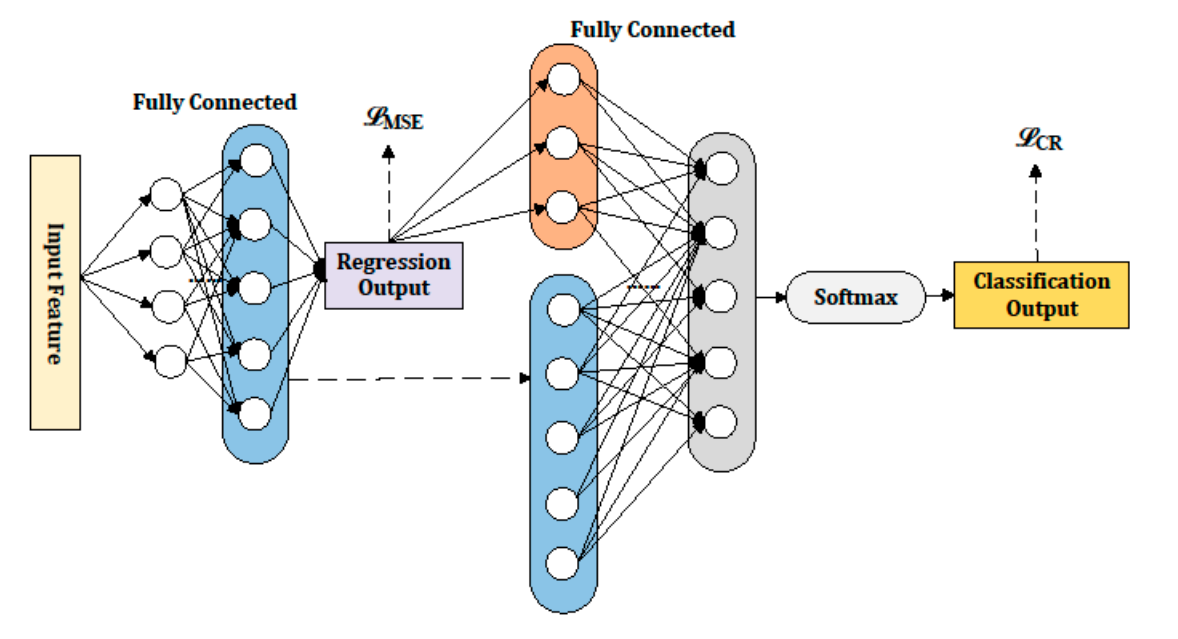
Figure 4. Neural network classification model. (Note:The same color represents the same set of parameters for the same set of neural networks.)